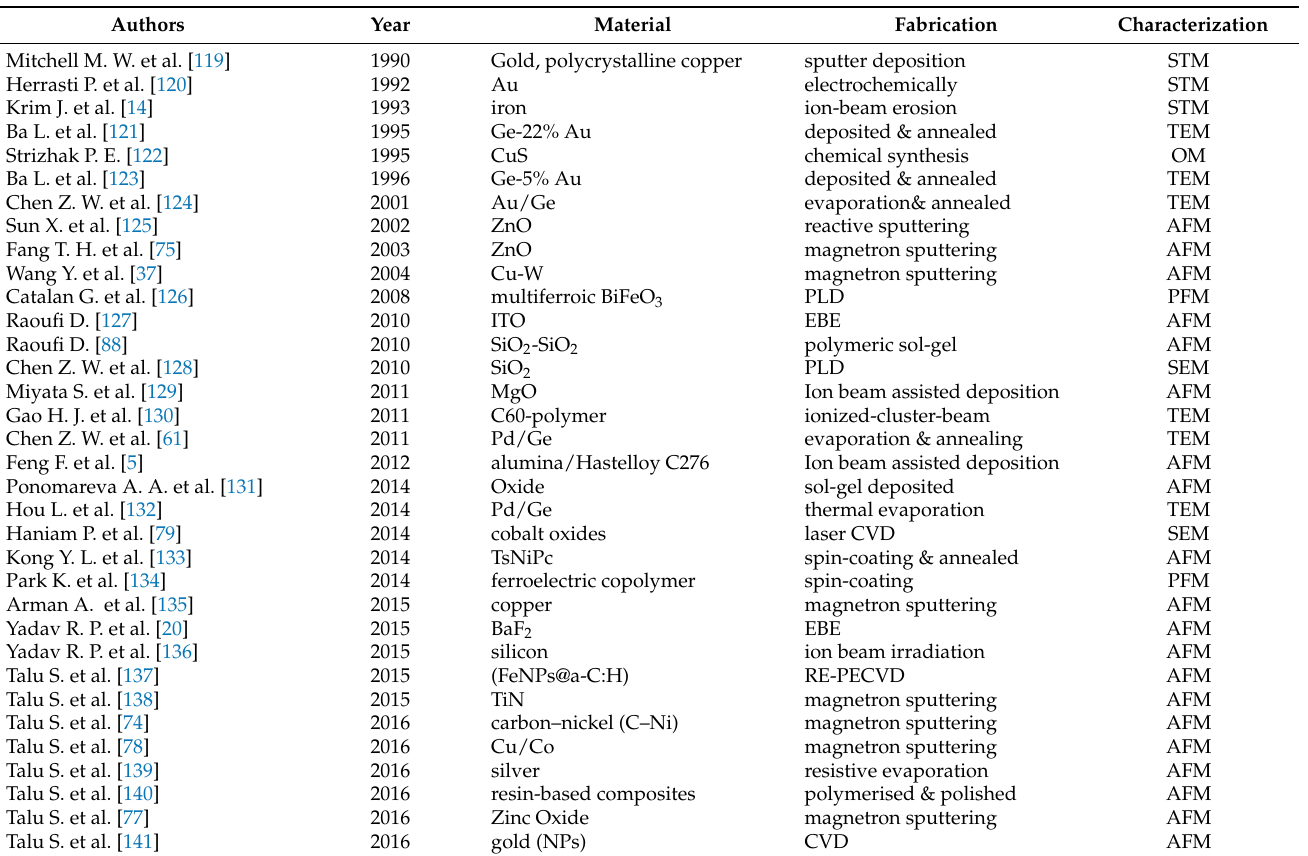
Table A2. Film types and characterization methods used when evaluating FDs